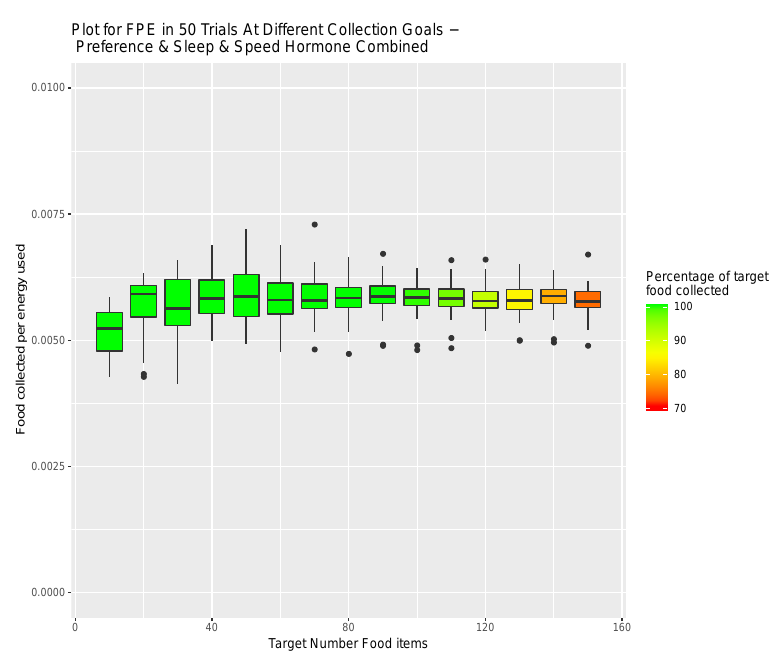
Figure 16. Hormone preference system combined with both the sleep and speed hormone system, tested in the environment containing two difference terrain types. Target number for items collected ranged from 10 to 150 items of food. Percentage of the items requested versus those collected by the end of the simulation is indicated by colour (Green 100% and Red <